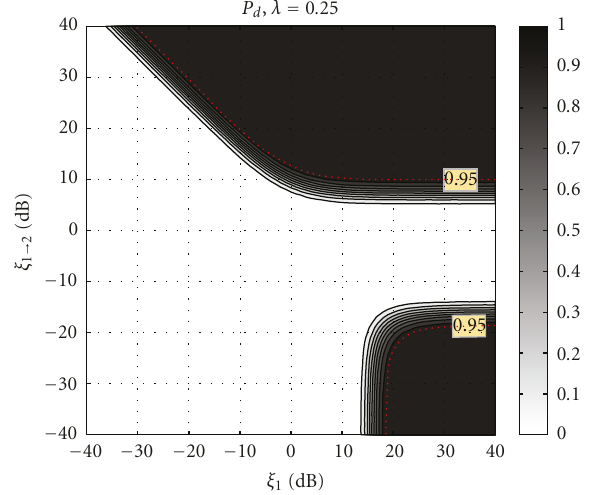
Figure 10: : Detection probability, P d , as a function of the SNR in block 1 and the SNR change from block 1 to block 2. The dotted red line highlights the cases where P d = 0 .